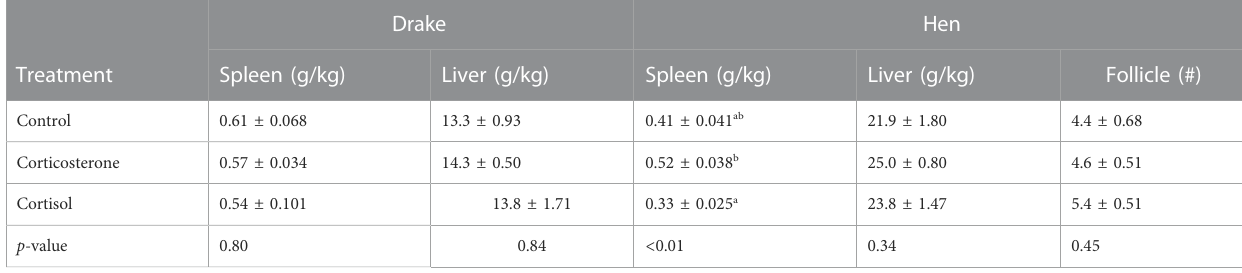
Values of spleen and liver are relative to the body weight (g/kg).